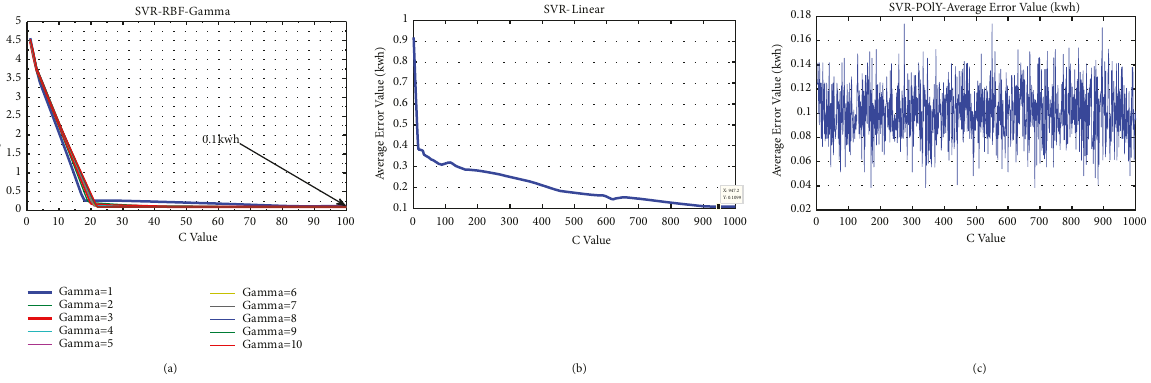
Figure 10: Convergence process in different kernel functions. (a) SVR-RBF-Gamma. (b) SVR-LINEAR. (c) SVR-POLY.